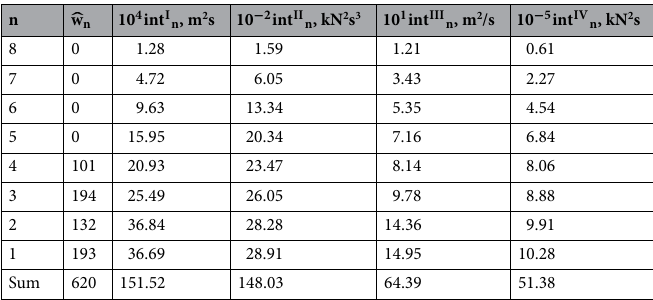
Table 5. Optimal design by Mulay and Shmerling 21